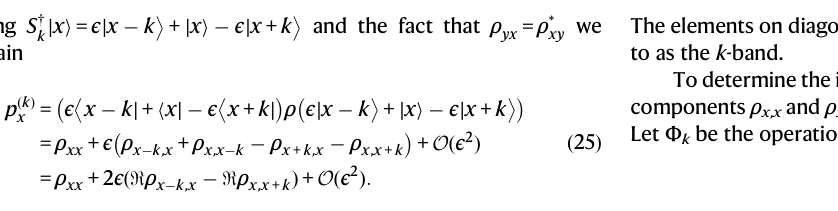
Fig. 7 | Theoretical analysis of measurement approach. a Effect of the mode- mixing operator S k [Eq. (23)] on the density operator ρ . b Behavior of the Bessel functions,whichdescribethemodulationoperators T δ [Eq.(31)]. c Themodulation operator T δ with δ ≈ k probes a k -band of ρ , i.e., the elements at most k above or